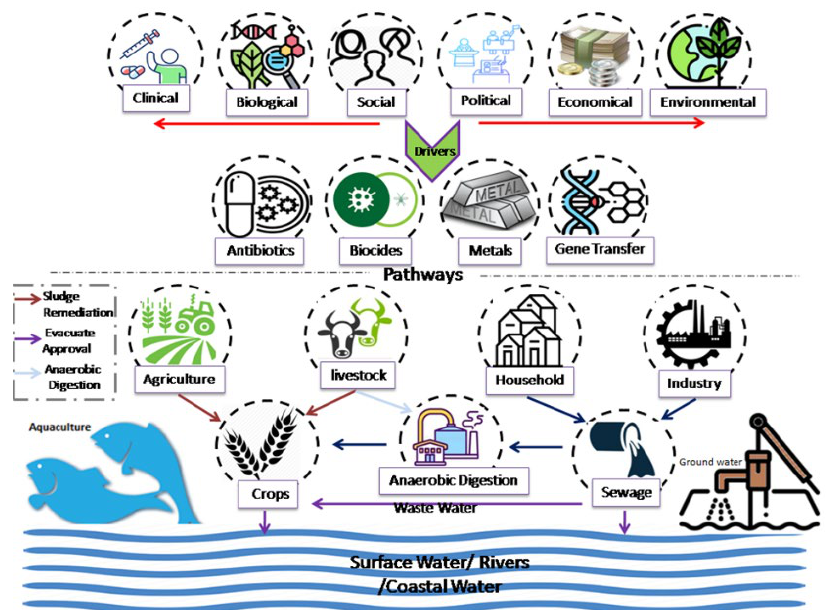
Figure 2. AMR is a global problem that impacts not only people but also animals and ecosystems, both domestic and nondomestic. It is fueled by clinical, biological, social, political, economic, and environmental factors. The presence of AMR bacteria in the environment is a consequence of all of these drivers.